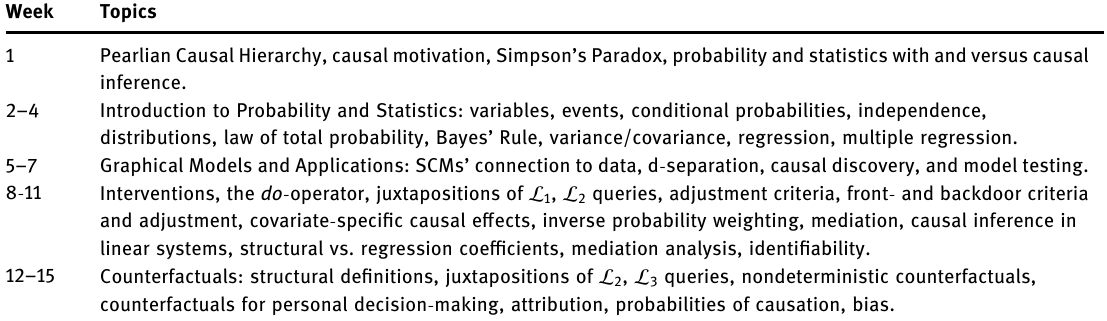
Table A1: Outline of topics in sample high - school treatment of causal inference. Also appropriate for an undergraduate course with extensions or added rigor in